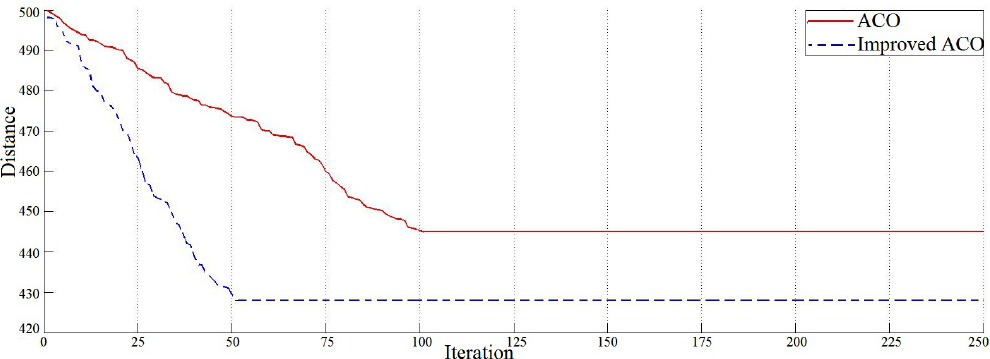
Figure 5. The result of the eil51